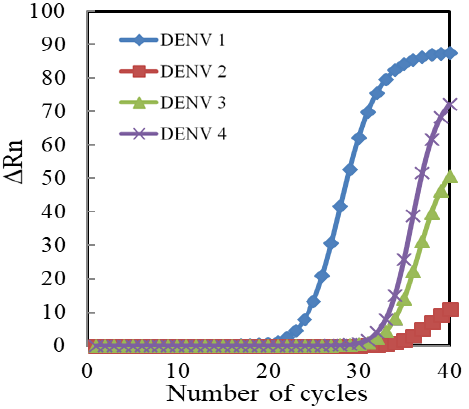
Figure 9. Fluorescence chart produced by real-time polymerase chain reaction (PCR) assay for the specificity of self-designed pDNA for four serotypes of 10 6 PFU/mL DENV.